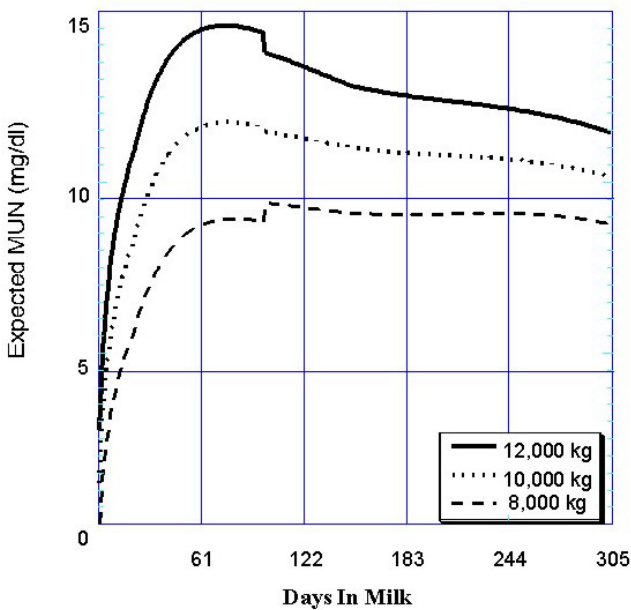
FIGURE 1. Predicted MUN (mg/dl) throughout a 305-day lactation for milk production of 12,000 kg (–––––), 10,000 kg/year ( ........ ) and 8,000 kg/year (- - - -).